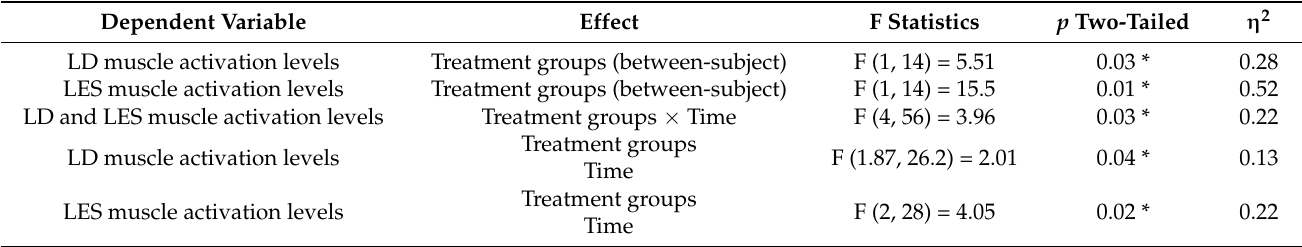
Table 8. Mixed-design repeated measures ANOVA test results with the forward bending posture (90 ◦ forward